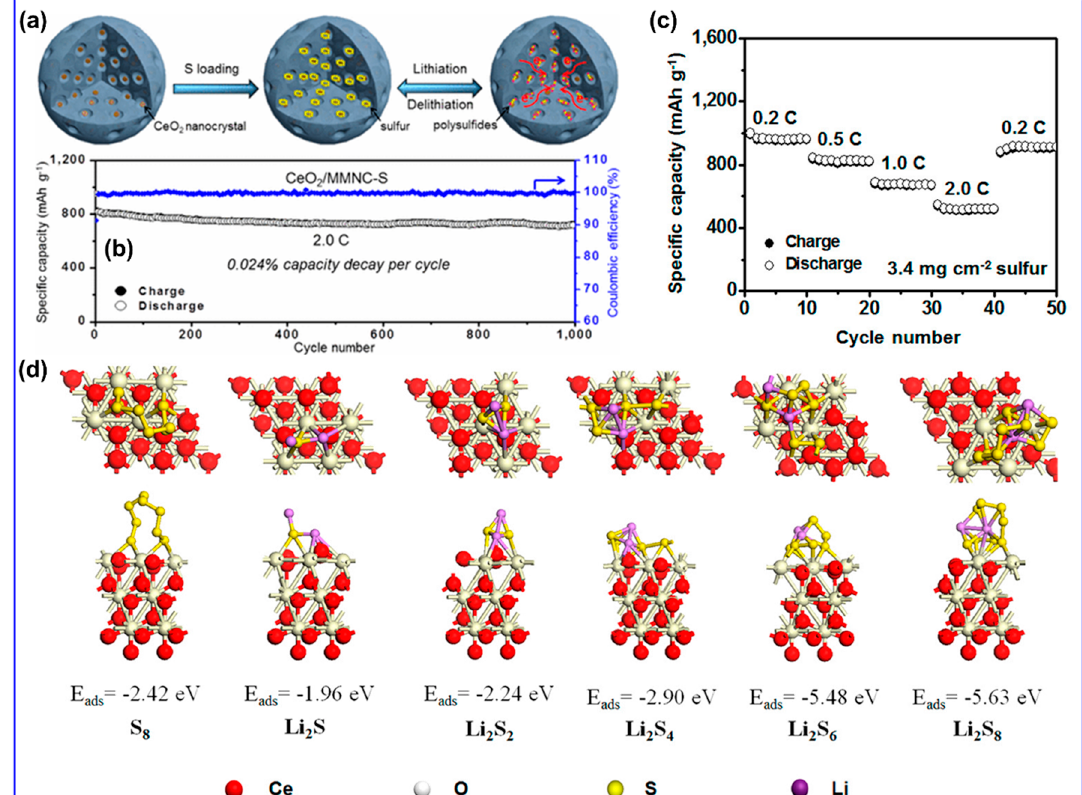
Figure 6. ( a ) Schematic representation of the functioning of CeO 2 nanospheres as sulfur hosts. ( b ) Cycling performance and corresponding coulombic e ffi ciency. ( c ) Rate performance of CeO 2 cathode. ( d ) Binding geometric configurations and binding energies of LiPS, Li 2 S, and S 8 with the (111) plane of CeO 2 nanocrystals. Reproduced with permission, Copyright, 2017, American Chemical Society